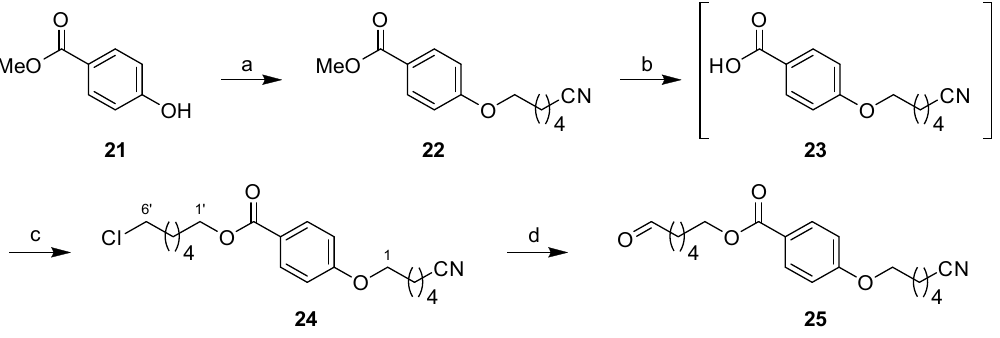
Figure 4. Building block concept for iminosugar-based ligands (R = CH 2 OH or H).